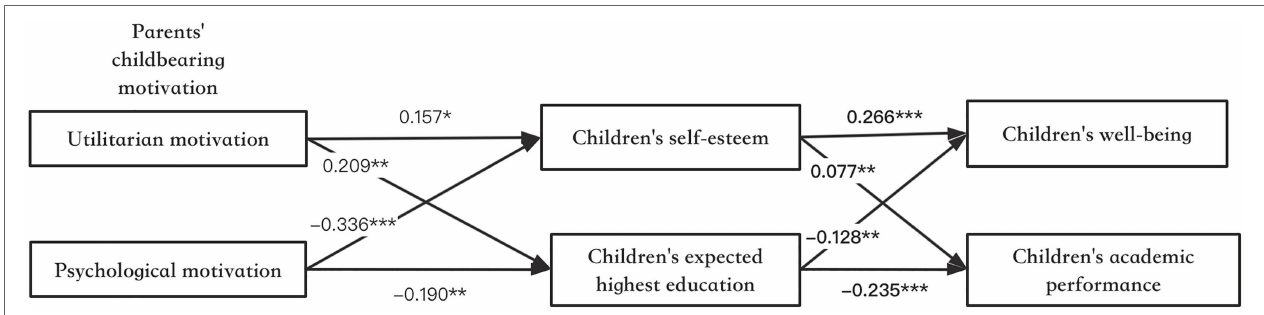
FIGURE 2 | SEM coefficients in the analytical model. Significance level: * p < 0.1, ** p < 0.05, and *** p <